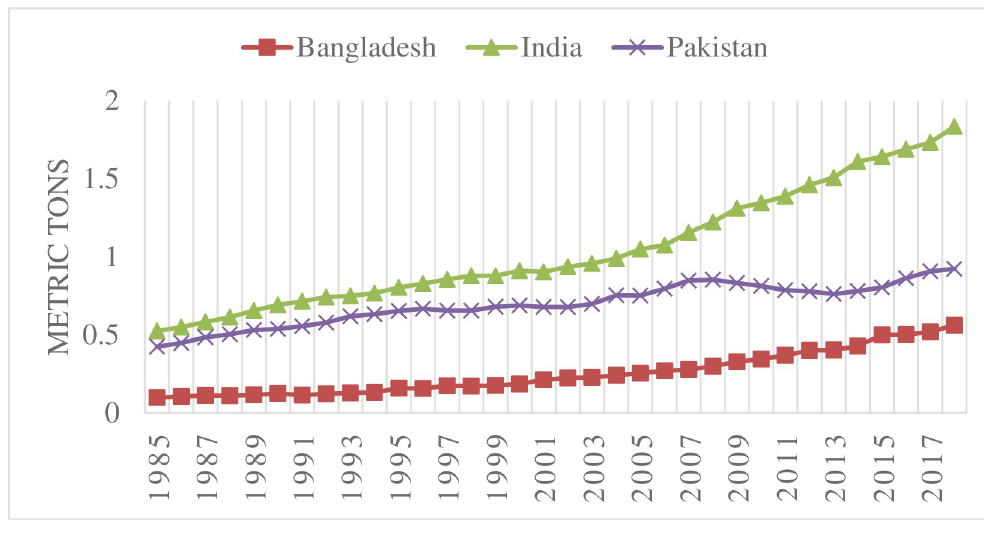
Fig 1. Carbon emissions per capita.